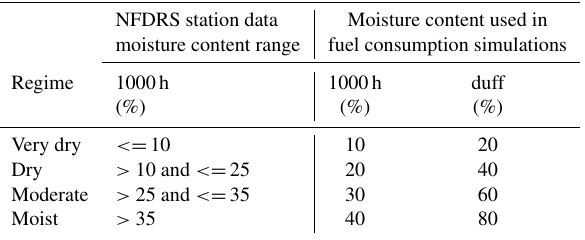
Table 5. Fuel moisture regimes used for simulating fuel consump-